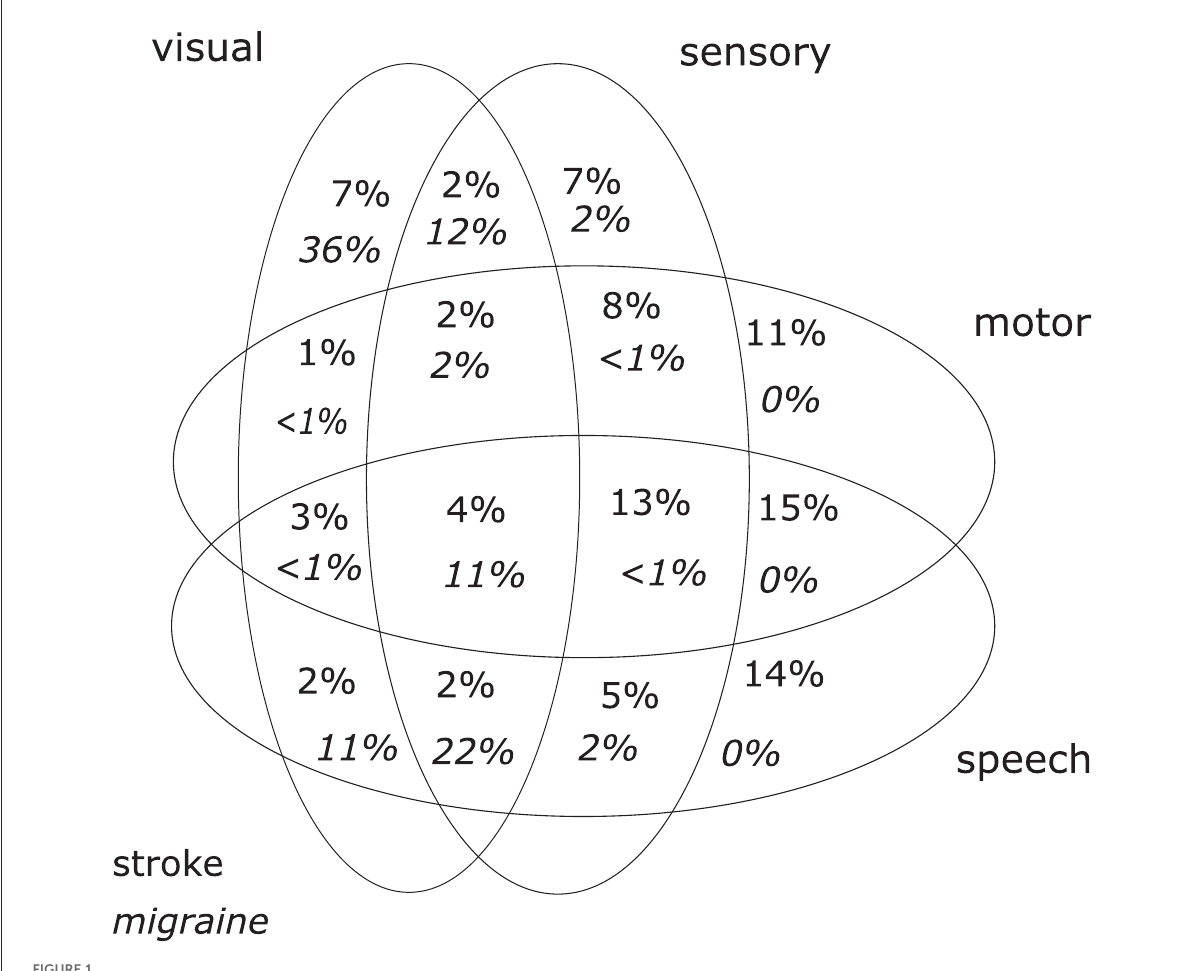
FIGURE1 Distribution of symptoms in ischemic stroke ( n = 350) and migraine with aura ( n =